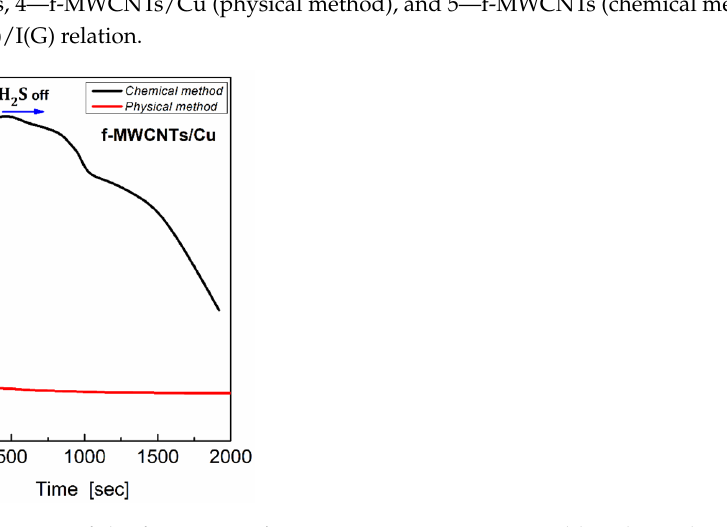
Figure 7. Selectivity of the sensors, prepared by ( a ) physical and ( b ) chemical methods. The recovering capability and the time spent recovering are among the most important requirements for sensors. This parameter determines their lifetime (repeated use) and durability. The results of the tests have shown that f ‐ MWCNTs/Cu ‐ based sensors may re ‐ cover within a few seconds after the influence of volatile and low ‐ impact gases and vapors (ethanol, methanol, methane, etc.). However, under the influence of H 2 S and am ‐ monia, both the reaction time and the recovery time of the sensing elements increase. It should be noted that the self ‐ recovery time of the chemically obtained sample is smaller compared to the sample obtained by EBE method (Figure 6). Various methods are used to reduce the recovery time and promote the self ‐ recov ‐ ery of the sensors, including UV light, heating, fans, etc. [38]. For example, most of the metal oxide ‐ based sensors operate at high temperatures and recover within several sec ‐ onds when separated from the gaseous medium by heating.